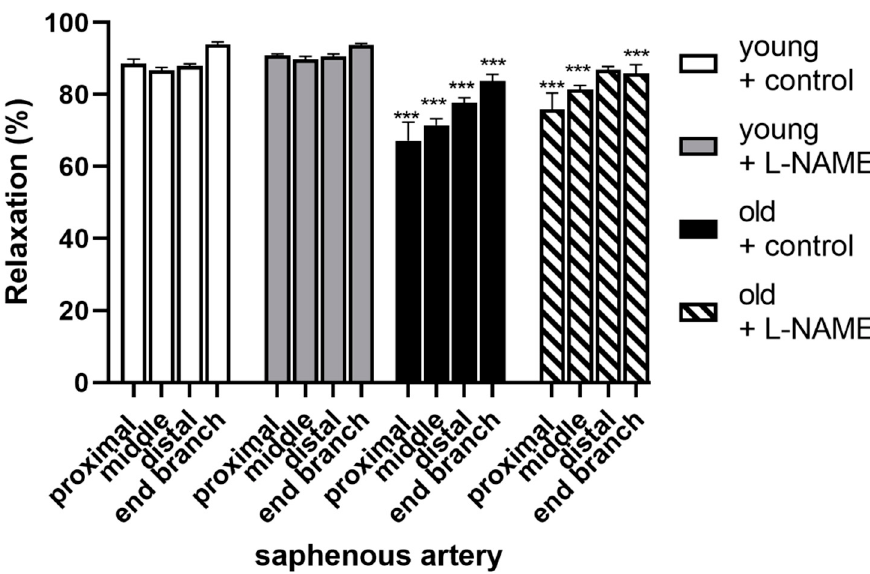
Figure 6. Nitroprusside-induced relaxations of proximal, middle, distal saphenous artery segments, and caudal (end) branches from (white and grey bars) young and (black and striped bars) old Sprague Dawley rats. Arteries treated as either controls (white and black bars) or with L-NAME (grey and striped bars). Relaxation % is the reversal of active tension by addition of 1 µ M nitroprusside in U46619-precontracted arteries. The results are expressed as mean ± S.E.M (young, n = 3–18; old, n = 3–6). Differences in relaxations of young vs. old were compared by 2way ANOVA with Bonferroni post hoc. *** p < 0.001, vs. treatment-matched artery in young